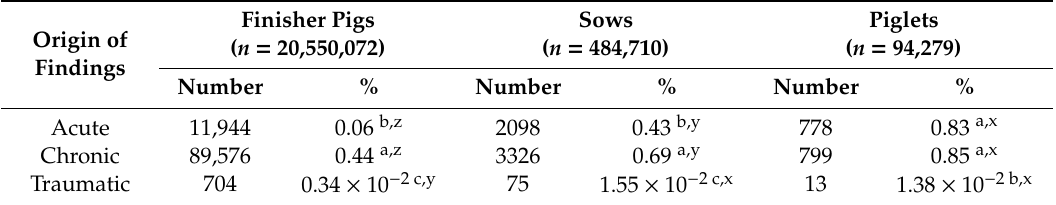
Table 6. Comparison of the number of individual patho-anatomic findings on the trunk of finisher pigs, sows and piglets slaughtered in the slaughterhouses.